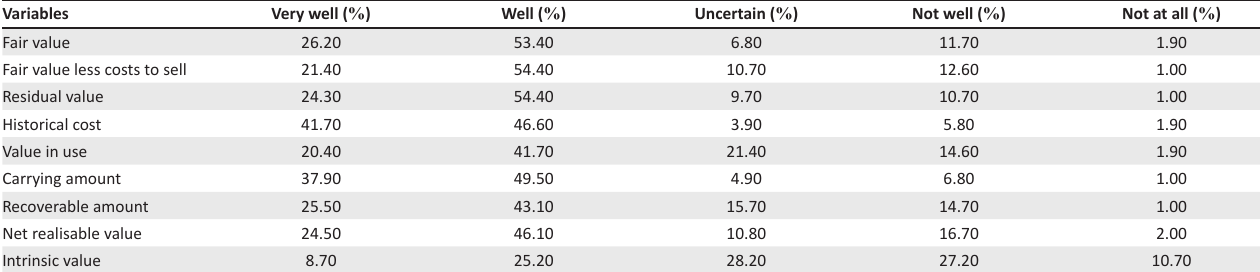
TABLE 5: Perceived level of understanding of the valuation concepts and methods. Variables Very well ( % ) Well ( % ) Uncertain ( % ) Not well ( % ) Not at all ( %